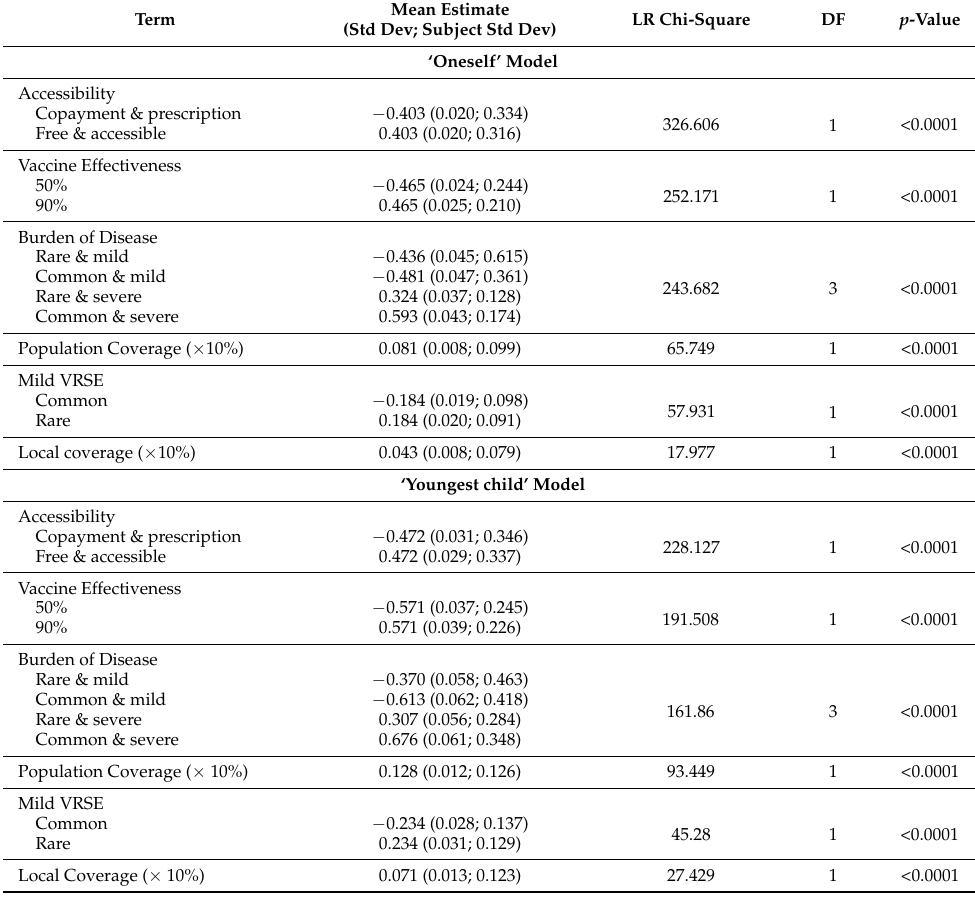
Table 3. Panel mixed logit model estimates (means and standard deviations) and significances of the attribute effects obtained from likelihood ratio (LR) tests. Belgium.